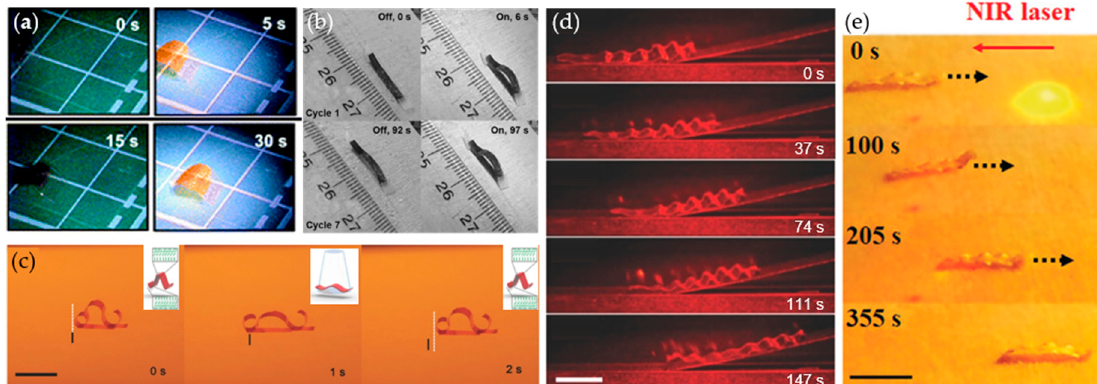
Figure 7. Crawling of liquid crystalline polymeric soft robots. ( a ) Photo-induced inchworm walking of the liquid crystalline polymer film by alternate irradiation with UV (366 nm, 240 mW · cm − 2 ) and visible light ( > 540 nm, 129 mW · cm − 2 ) at room temperature. ( b ) A light-driven caterpillar-inspired soft robot with alternated hybrid alignment (inset image). The initial bent shape deforms to flat geometry under visible light (448 nm, 150 mW · cm − 2 ). ( c ) Near-infrared (NIR)-light-driven walking carbon nanotube-liquid crystalline elastomer (CNT-LCE) / silicon bilayer soft robot. ( d ) Climbing a hill using the crawling motion of the soft robot. ( e ) Crawling of the wrinkle-shaped soft robot against the laser scanning direction (NIR, 980 nm, 4.5 W · cm − 2 ). The top of film was alternately crosslinked / decrosslinked, whereas the bottom of the film was fully decrosslinked. ( a ) Reproduced with permission [12]. Copyright 2009, Royal Society of Chemistry. ( b ) Reproduced with permission [13]. Copyright 2017, Wiley-VCH. ( c ) Reproduced with permission [20]. Copyright 2013, Wiley-VCH. ( d ) Reproduced with permission [21]. Copyright 2016, Wiley-VCH. ( e ) Reproduced with permission [22]. Copyright 2019, Wiley-VCH.